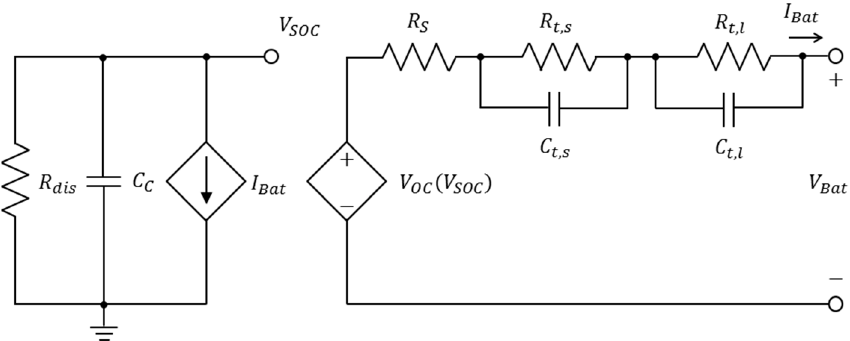
Figure 3. Runtime-based model .